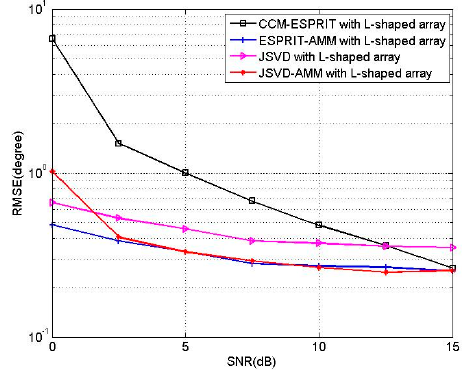
Figure 12. RMSE of four algorithms versus SNR.